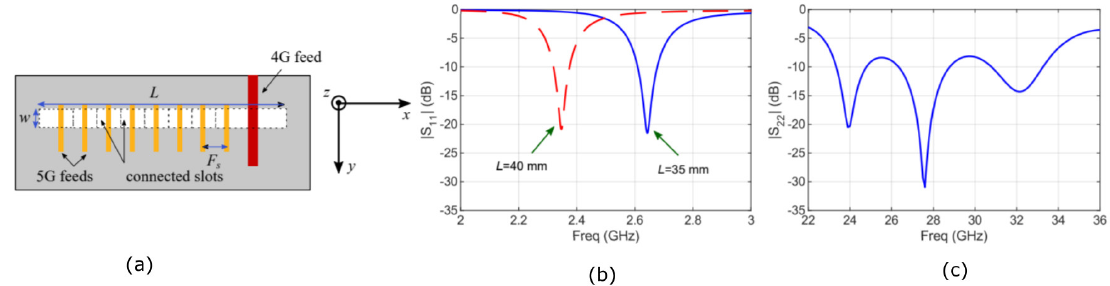
Figure 15. CSAA consists of 8 feeders for the mm − wave band and one feeder for the low band, ( a ) CSAA configuration, ( b ) reflection coefficient at lower band, and ( c ) reflection coefficient at the upper band.